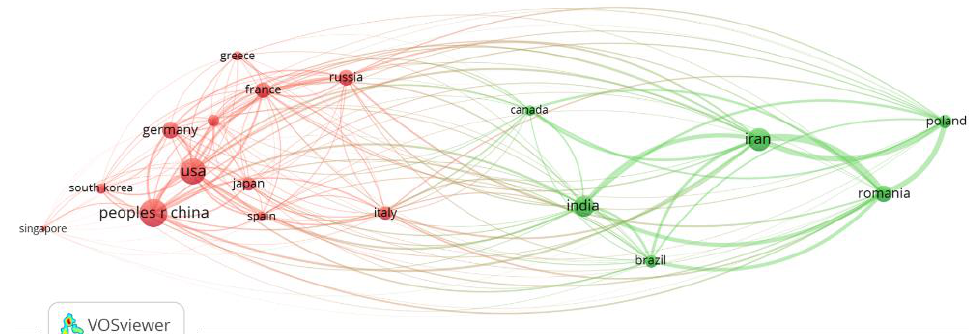
Figure 8. A network map showing bibliographic coupling of countries on the research subject of fractal theory in thin films. A threshold of 5 and minimum number of 500 citations was used in the analysis.